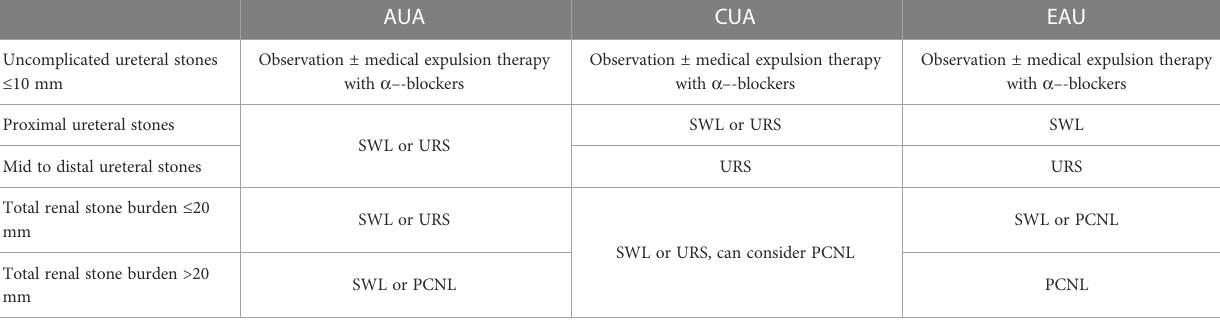
TABLE 3 Summary of treatment recommendations for pediatric stone disease based on stone size and location.